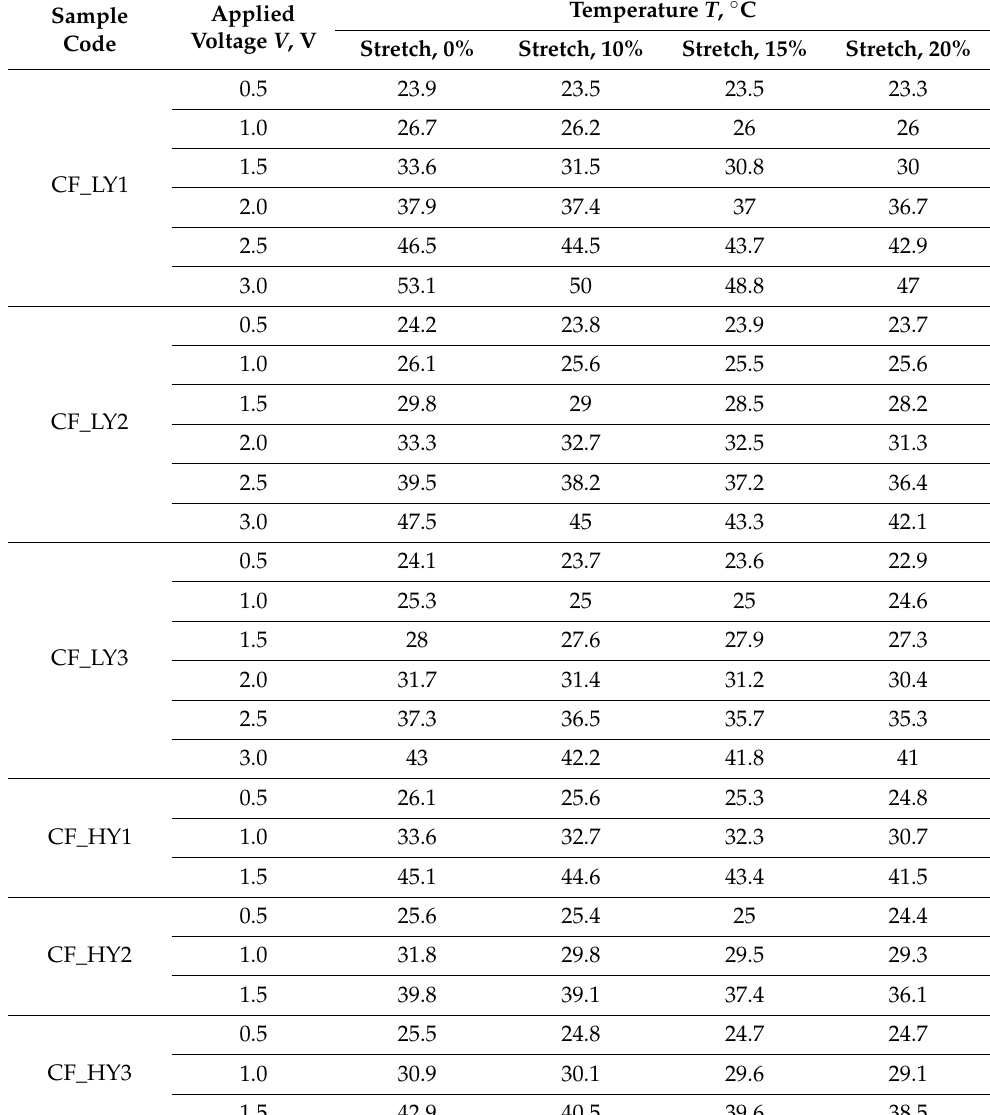
Table 4. Voltage–temperature characteristics at different stretching levels of developed electro- conductive composite fabrics for 60